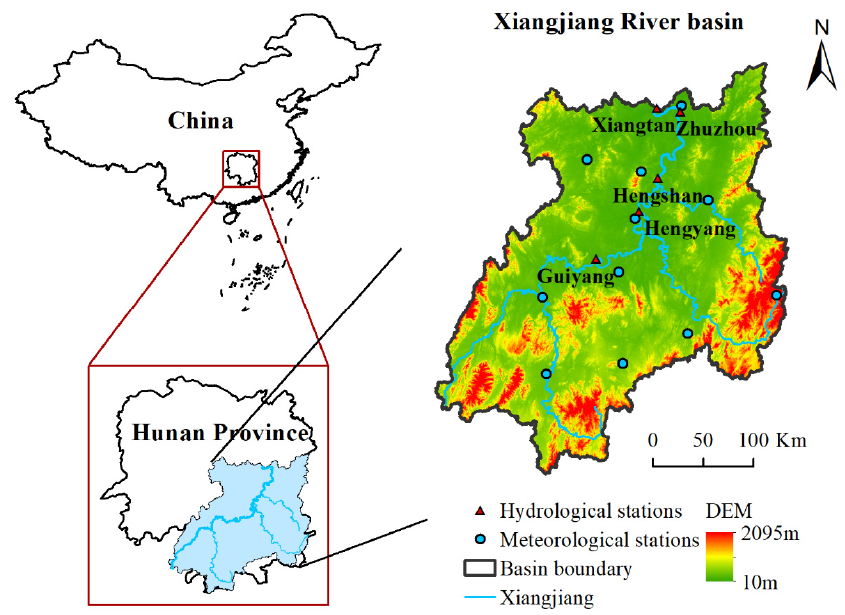
Figure 1. Map of the Xiangjiang River basin (XJRB), including the location, digital elevation model, drainage network, and hydrologic and meteorological stations.